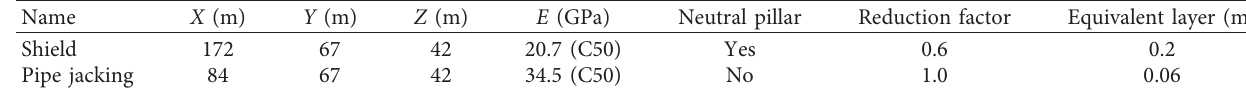
Figure 6: Tail void of shield and pipe jacking: (a) Shield tail void. (b) Pipe jacking tail void. Table 1: Model size and structural